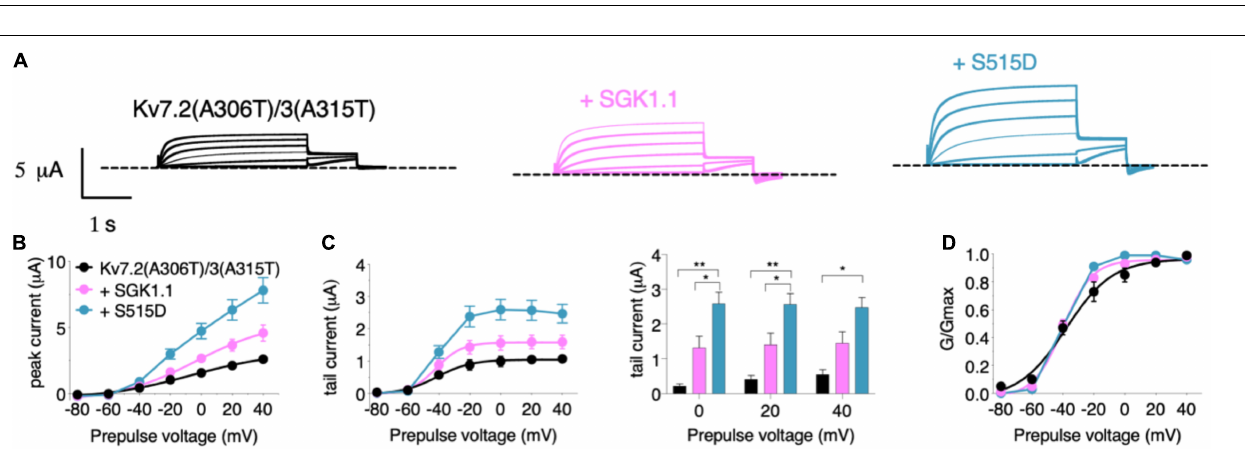
FIGURE 3 | Constitutively active form SGK1.1 (S515D) upregulates Kv7.2 epilepsy mutation R207W in heteromeric assembly with Kv7.3 while WT SGK1.1 fails to. (A) Schematic representation of Kv7 channel structure. The basic organization of potassium channels is a tetramer with each monomer containing one pore-forming domain (PD) (transmembrane segments S1-S4) and a voltage sensor domain (VSD) (transmembrane segments S5-S6). Epilepsy mutants are represented as colored pentagons (R207W in red and A306T in yellow). (B) Currents elicited in Xenopus oocytes after coinjection of cDNAs from Kv7.2 (R207W)/3 channel alone (first panel) or in combination with wild-type (second panel) or constitutively active (third panel) SGK1.1. (C) Peak current/voltage relationship. (D) Tail current (left) and tail currents measured at –30 mV after 0, + 20 or + 40 mV depolarizing pulses for the indicated construct combinations (right). Values represent mean ± SEM (Two-way ANOVA, Tukey’s correction for multiple comparisons; ns, not significant; ** p < 0.01; *** p < 0.0005; **** p < 0.0001). (E) Normalized conductance. Legends are indicated on (C) .